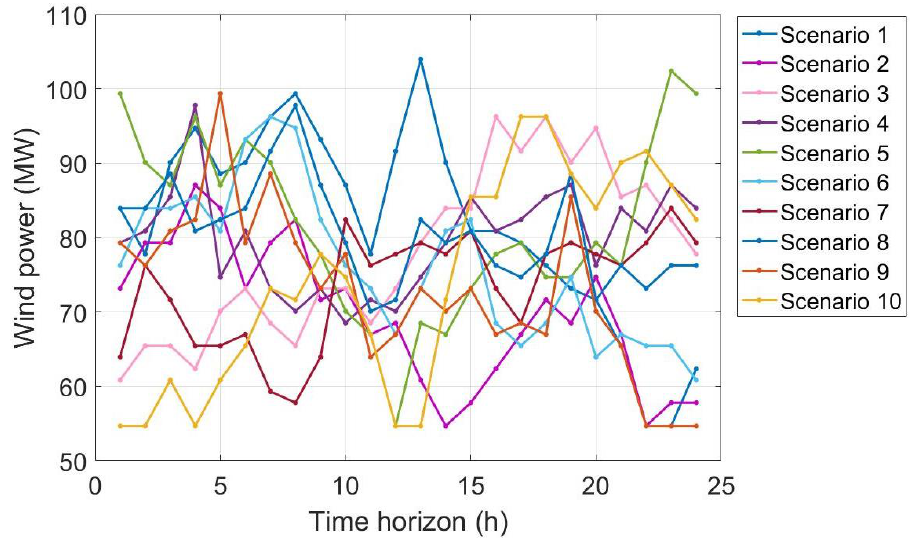
Figure 3. Ten representative scenarios of wind power.